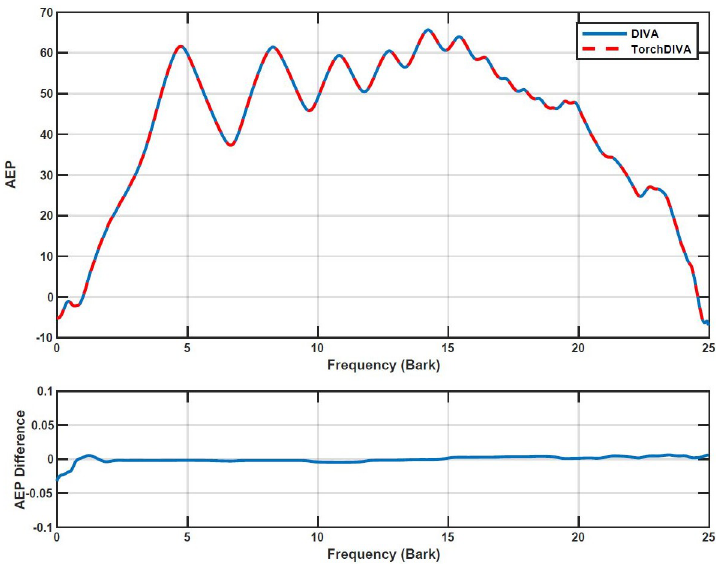
Fig 6. DIVA and TorchDIVA auditory excitation pattern comparison. Speech production ‘happy’ auditory excitation pattern (AEP) comparison for DIVA and TorchDIVA. The first subplot is the AEP, the second subplot is the difference between the two AEPs